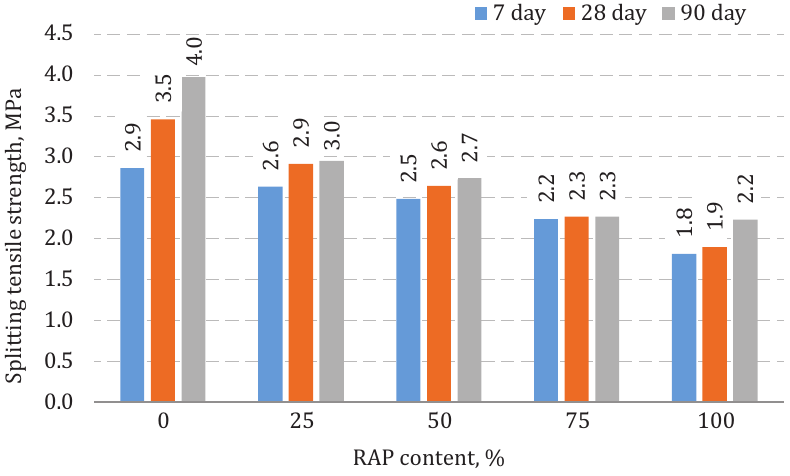
Figure 10. Splitting tensile strength of the mixtures containing RAP at different ages